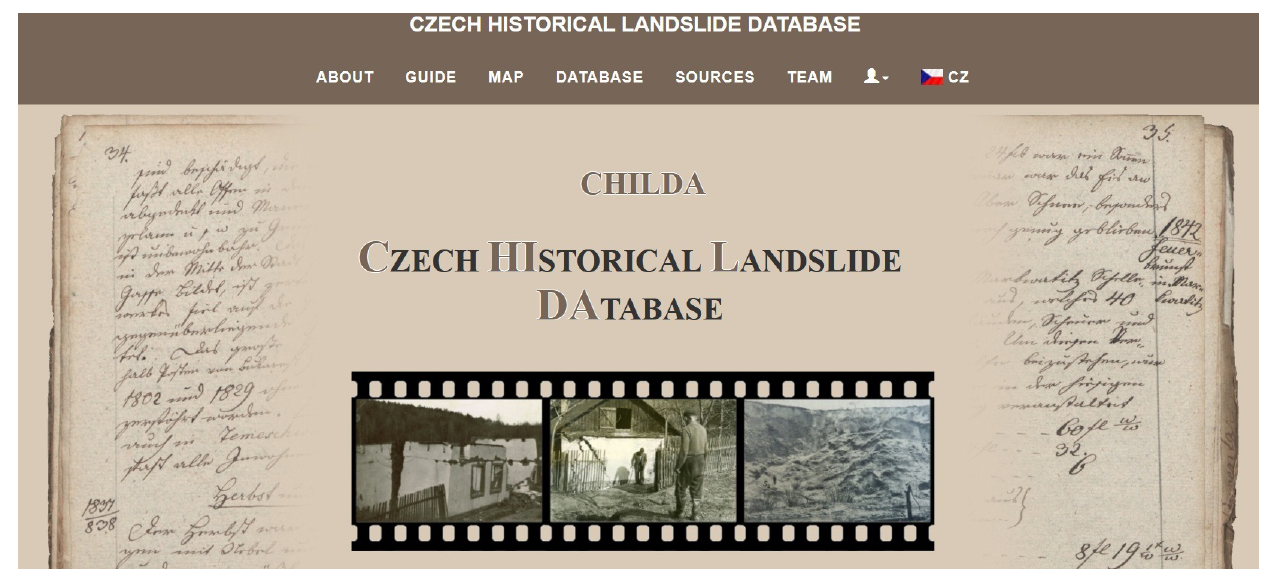
Figure 3. Title page of CHILDA (https://childa.cz/?lang=en, last access: 19 August 2021).